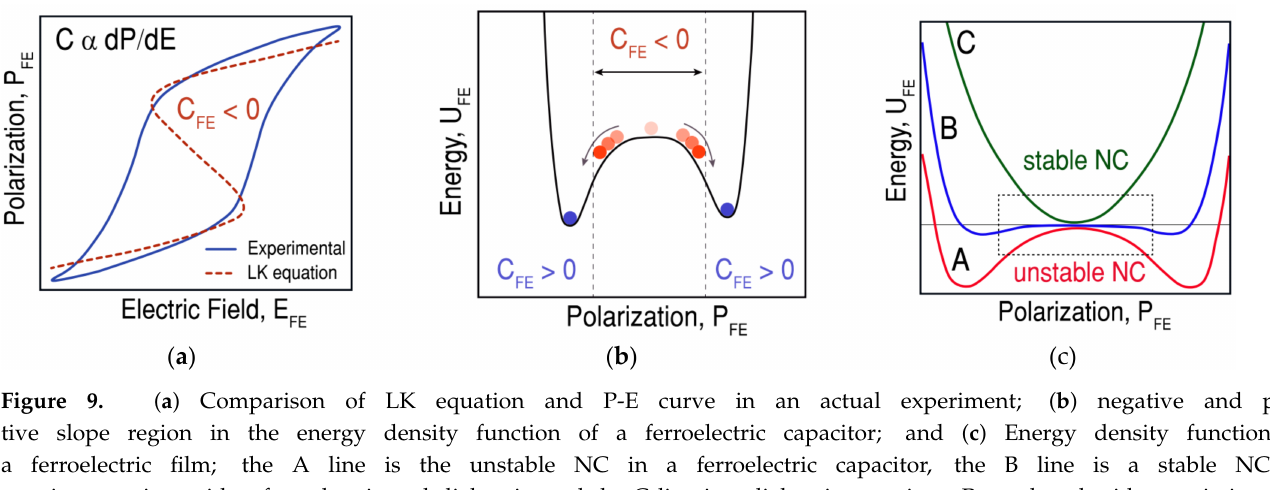
Figure 9. ( a ) Comparison of LK equation and P-E curve in an actual experiment; ( b ) negative and posi- tive slope region in the energy density function of a ferroelectric capacitor; and ( c ) Energy density function of a ferroelectric film; the A line is the unstable NC in a ferroelectric capacitor, the B line is a stable NC in a series capacitor with a ferroelectric and dielectric, and the C line is a dielectric capacitor. Reproduced with permission [86]. Copyright 2019, Springer Nature Limited.